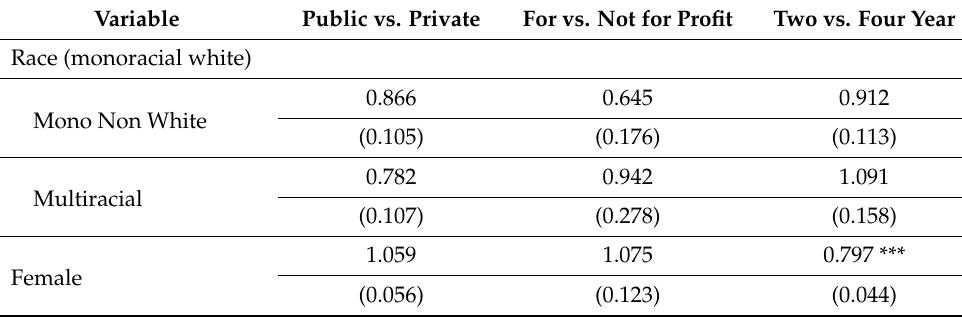
Table A2. Logistic Regression of School